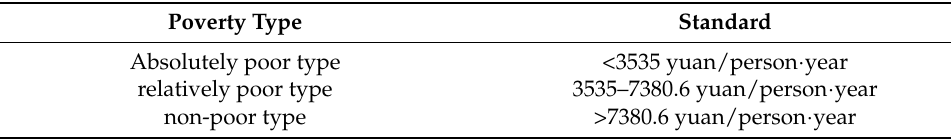
Table 2. Standard classification of poverty types of